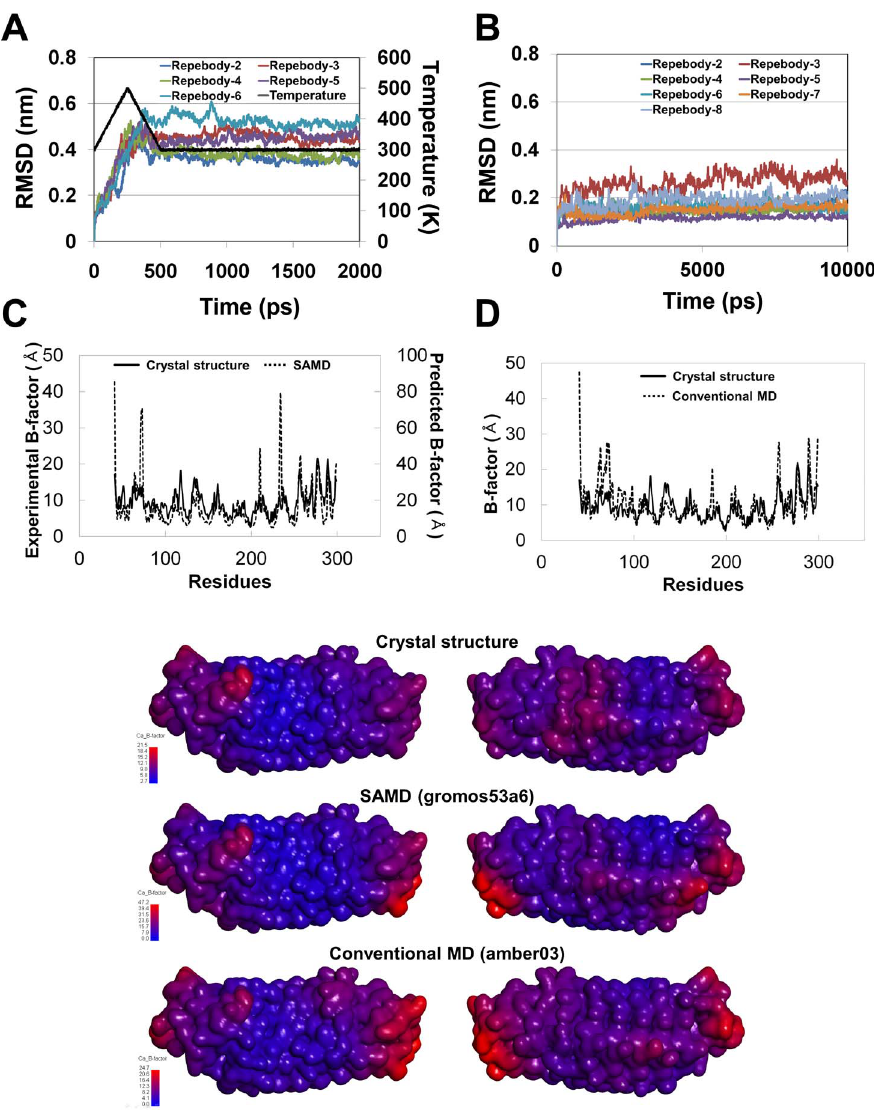
Figure 2. RMSD values of repebodies with different numbers of LRR module under simulated annealing (A) and conventional procedure (B). Comparison of B-factors between crystal and simulated annealing (C) or conventional MD (D) structures. (E) B-factor contour maps on the surface of repebody-5 based on different simulation methods. Predicted B-factor values based on simulated RMSF were obtained by using the conversion formula: B-factor=(8 p 2 /3)RMSF 2 [32]. ( Table 1 ). Of these energies, long range coulomb energy in reciprocal space (Coul. Recip. energy) was shown to be the most correlated energy property, displaying the highest linear correla- tion coefficient ( r = 2 0.72) between the module numbers and the energy. In addition, hydrophobicity of buried hydrophobic residues was also calculated to check the thermodynamic stability. Each hydrophobicity value of the proteins with increasing module numbers ranging from 2 to 6 was 197.1, 239.7, 262.7, 273.0, and 316.0, respectively ( Table 1 ). The hydrophobicity was shown to be most closely correlated ( r =0.92) with thermodynamic stability of the proteins. From these calculations, appropriate intra- molecular properties including backbone H-bond and Coul.